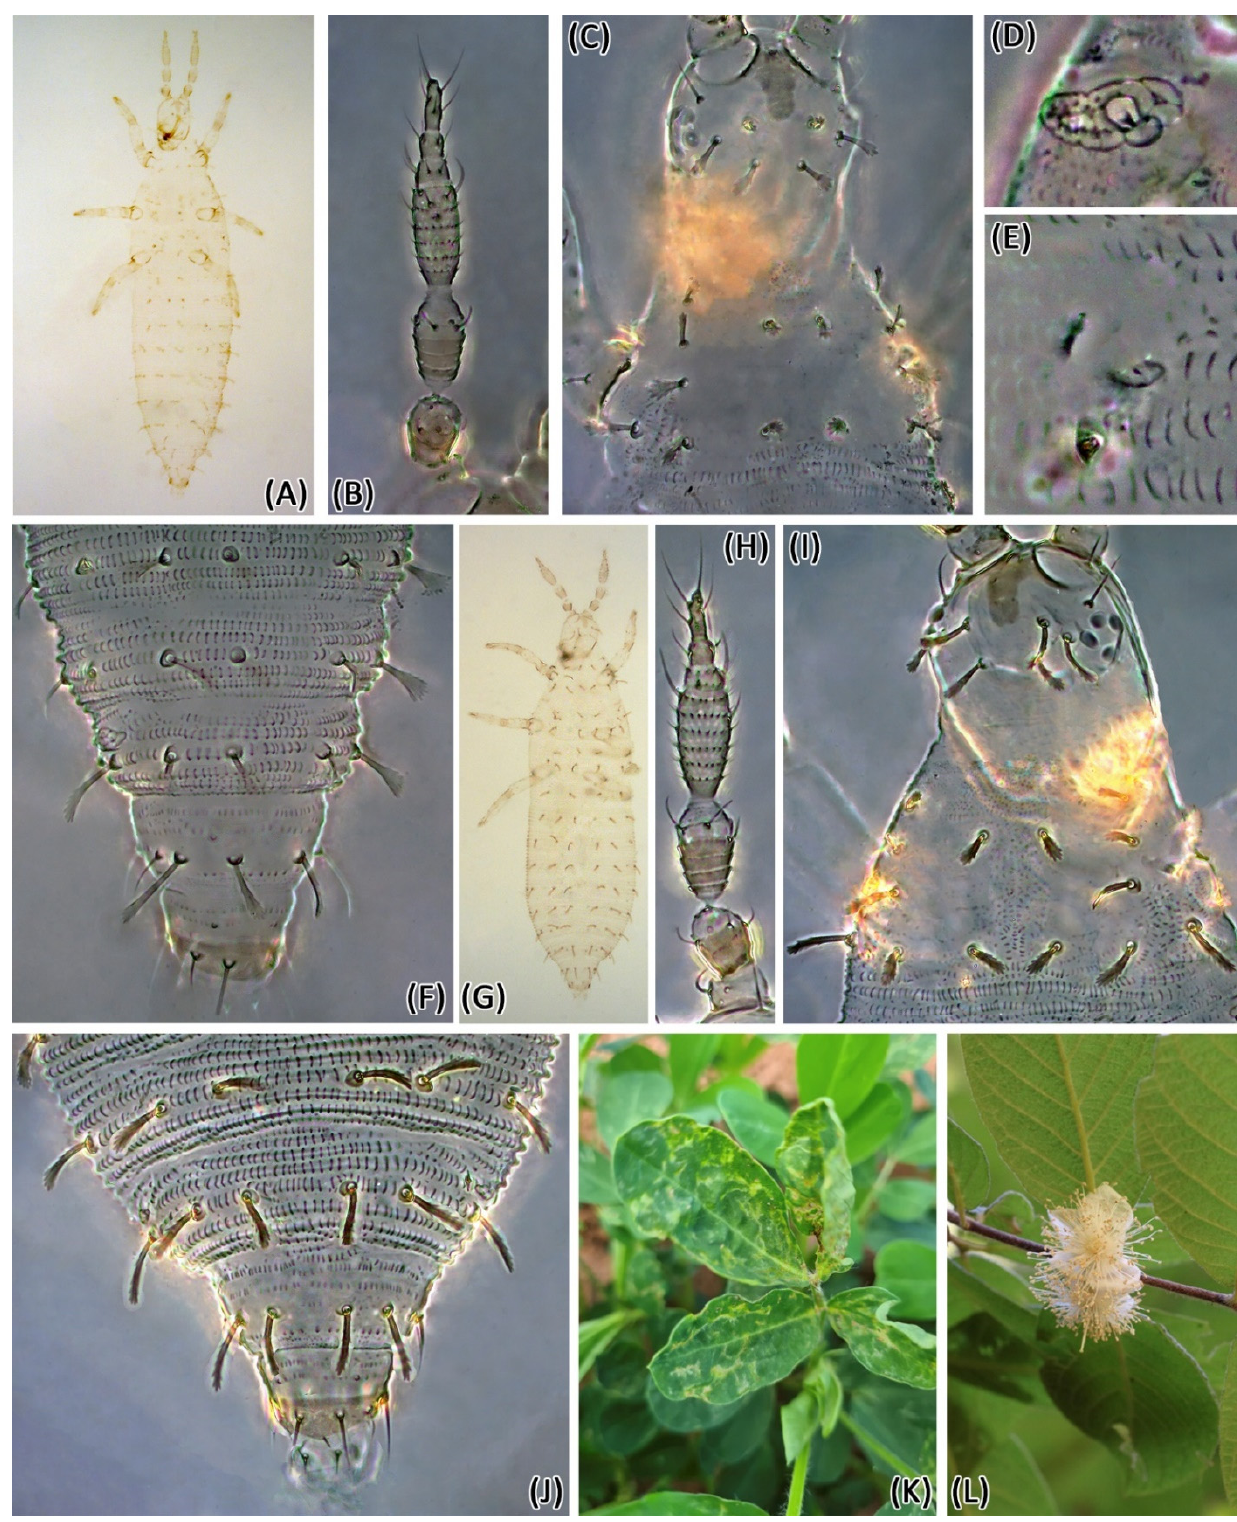
Figure 3. Enneothrips spp. larvae II and hosts. Enneothrips enigmaticus sp. n.: ( A ) Habitus; ( B ) Antenna; ( C ) Head and pronotum; ( D ) Mesothoracic spiracle; ( E ) Abdominal tergite II spiracle; ( F ) Abdominal tergites VI-X. Enneothrips flavens : ( G ) Habitus; ( H ) Antenna; ( I ) Head and thorax; ( J ) Abdominal tergites. ( K ) Damage of E. enigmaticus sp. n. on peanut leaflets; ( L ) Campomanesia guazumifolia , host of E. flavens .